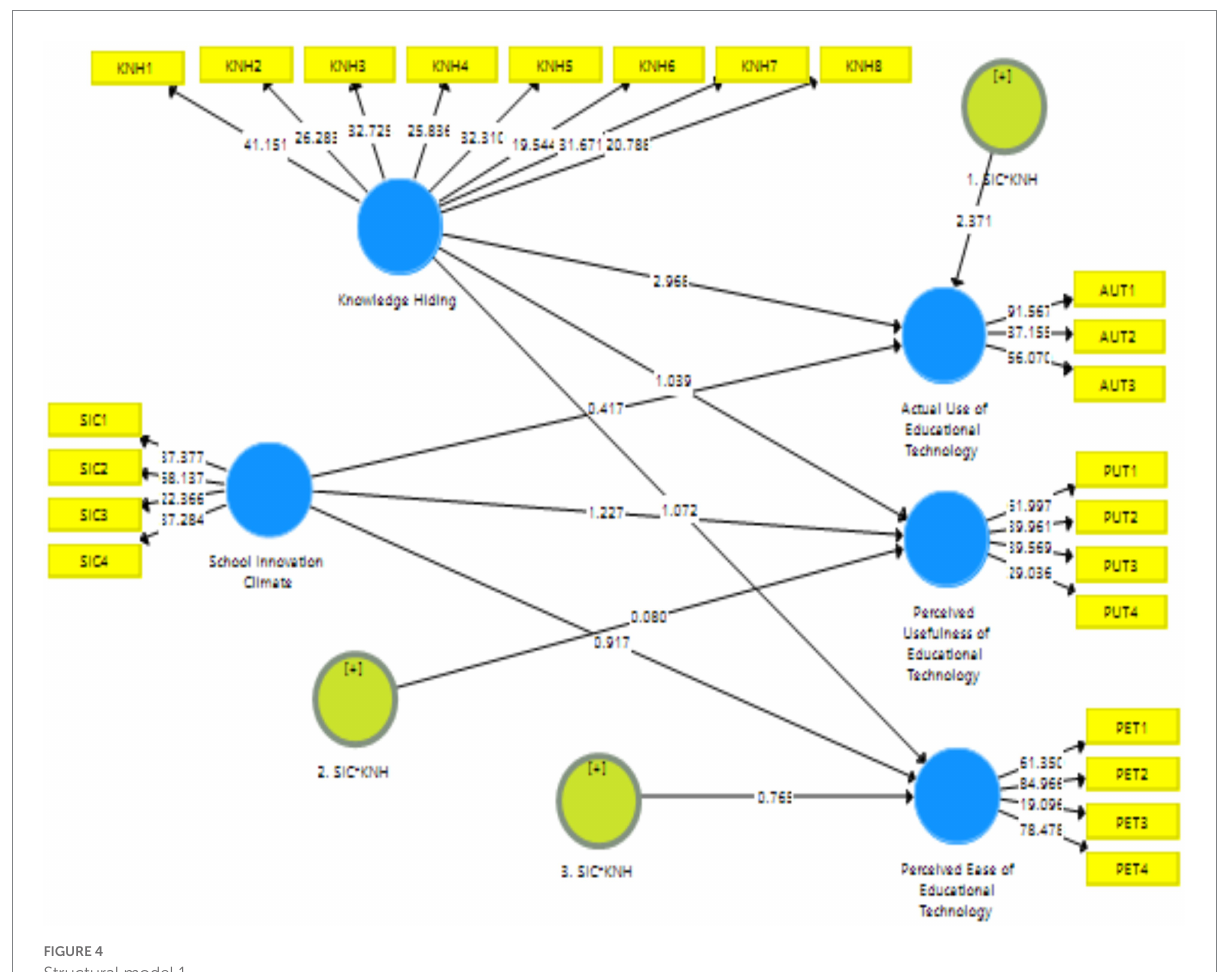
FIGURE 4 Structural model 1.